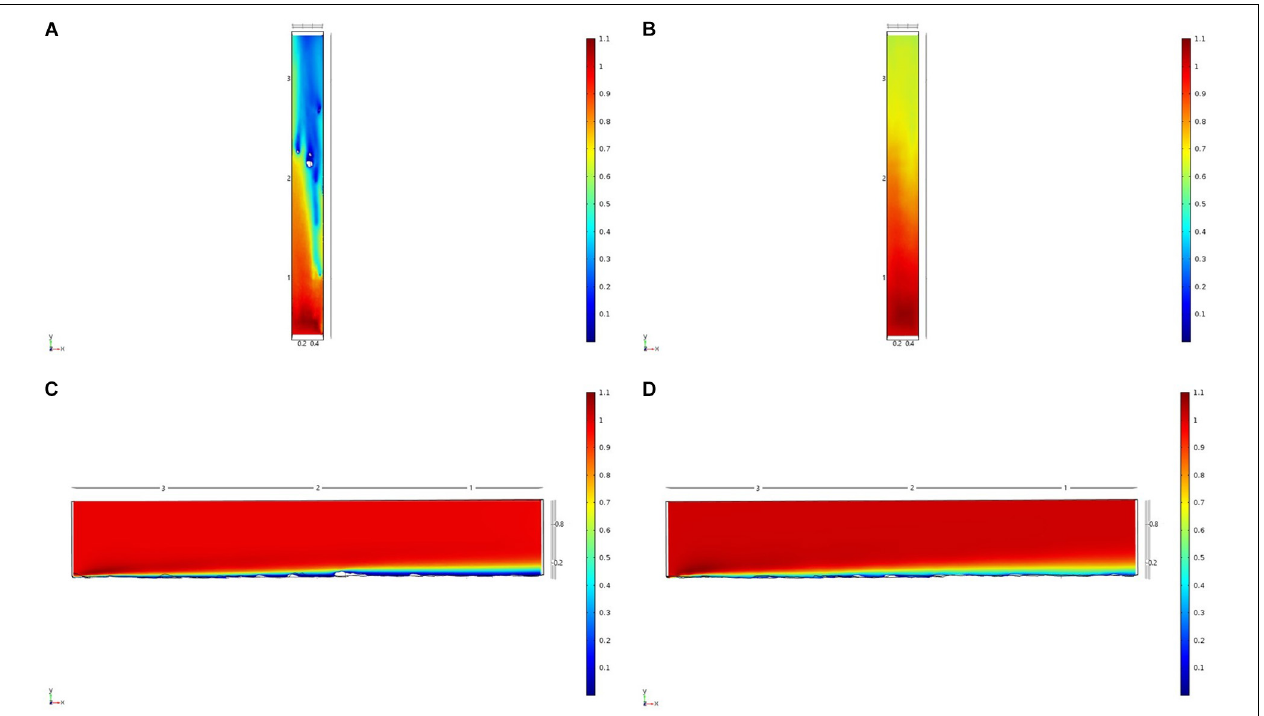
FIGURE 7 | Results of the fluid flow finite element analysis simulation for surface models for Nuuk Study area visualized as two-dimensional plots (horizontal and vertical cross sections) of flow velocity magnitude (false-color scales m/s). (A,C) Surface model with sponges present (B,D) surface model with sponge structures removed. Scale in m with ambient flow of 1 m/s along the y